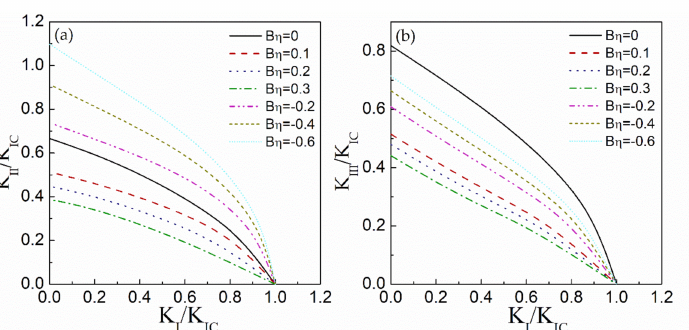
Figure 16. Mixed fracture toughness–predicted values of the fracture criterion under plane strain with ν = 0.35. ( a ) The mixed mode I/II fracture toughness–predicted values. ( b ) The mixed mode I/III fracture toughness–predicted values.